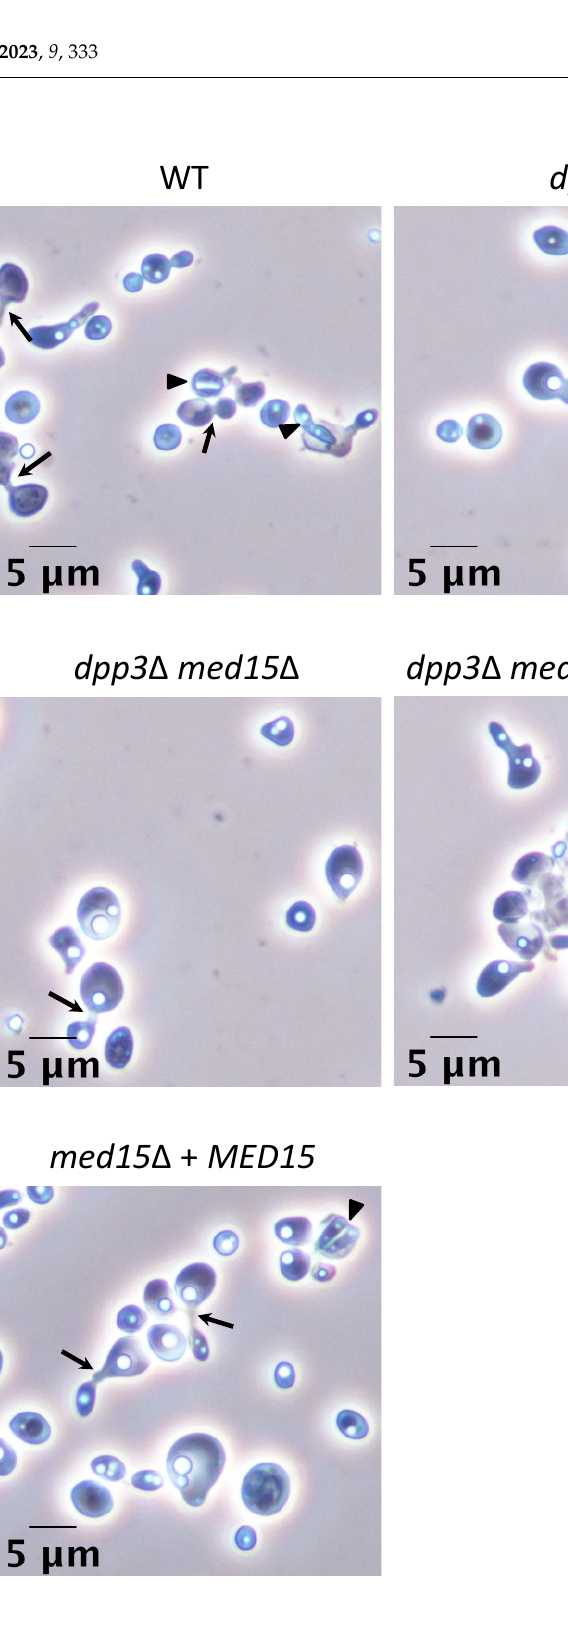
Figure 4. The mating defect in the dpp3 ∆ mutant is conferred by the med15 ∆ mutation. WT and mutant strains of C. lusitaniae ( MAT a ) were crossed with the CL38 strain ( MAT α ). Images were taken after 48 h of incubation at 30 °C. Scale bars represent 5 μ m. Asci are indicated by arrowheads, and conjugation tubes by arrows.